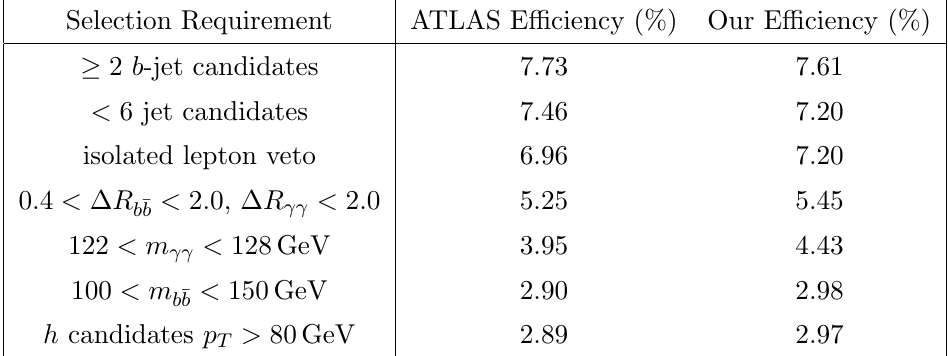
Table 5. Cut (cid:13)ow for the signal process hh b (cid:22) b(cid:13)(cid:13) using the ATLAS event selection criteria. ! Shown are the results taken from [8] and the results obtained with the MC samples